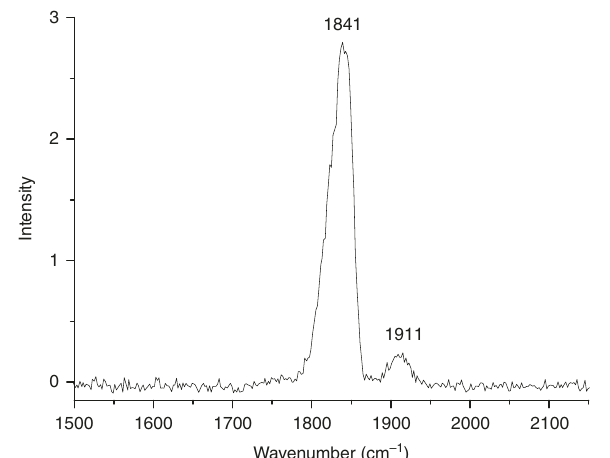
Fig. 2 Infrared photodissociation spectrum of the 11 BFe(CO) 3 − anion complex. The spectrum is measured in the carbonyl stretching frequency region by monitoring the CO photodissociation channel. Intensity is shown as the yield of fragmentation ion normalized to the parent ion signal in